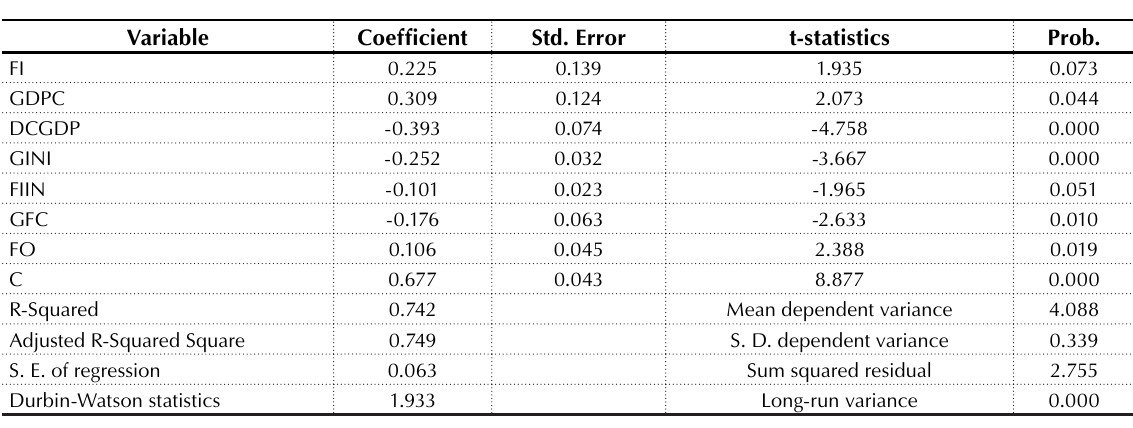
Table 7. Results of FMOLS